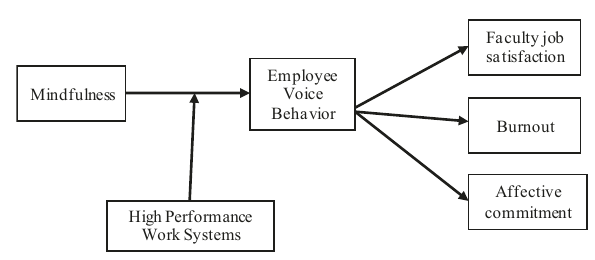
Fig. 1 Proposed model of the study. Mindfulness